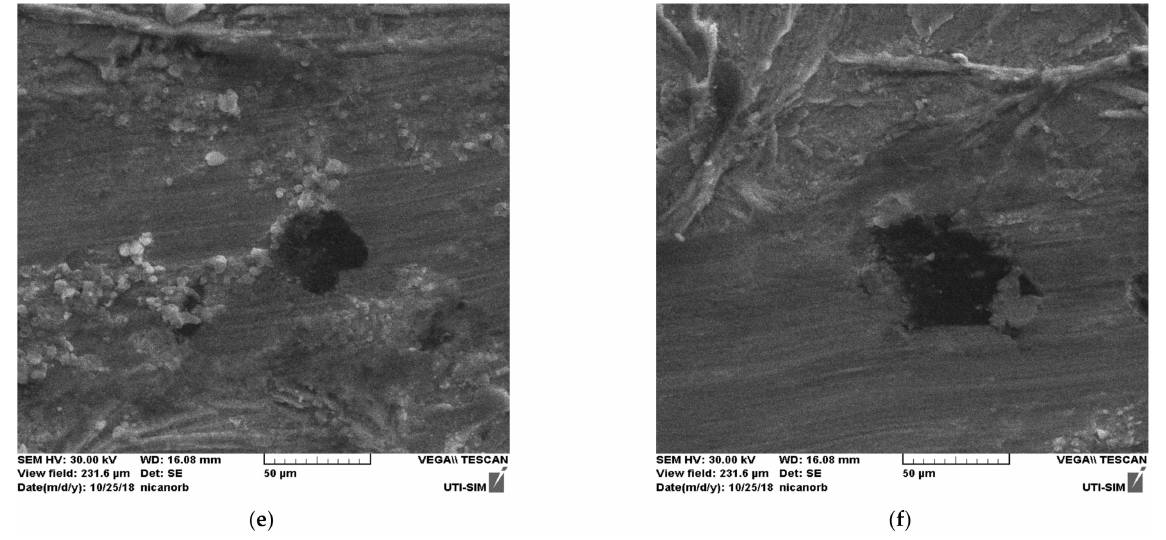
Figure 15. Scratch test for phosphate nodular cast iron sample at size scales of: ( a ) 500 µ m; ( b ) 500 µ m;